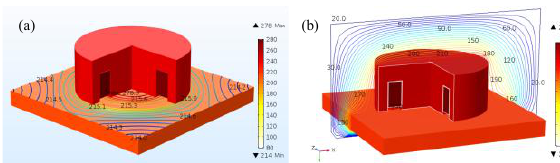
Fig. 4. Thermal field distribution of (a) gripper and attracted surface and (b) the air surrounding the object for current value of I =1